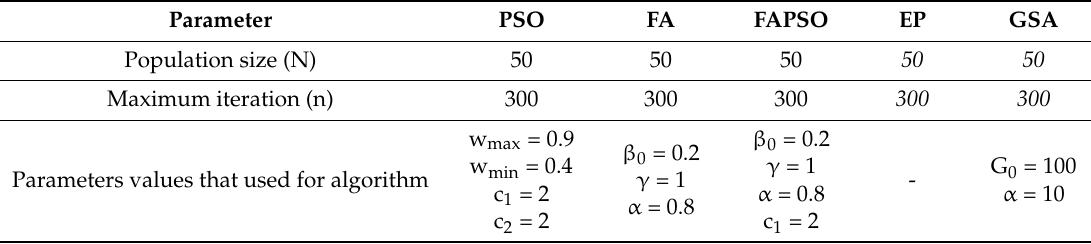
Table 3. Particle Swarm Optimization (PSO), Firefly Algorithm (FA), Firefly Algorithm—Particle Swarm Optimization (FAPSO), Evolutionary Programming (EP) and Gravitational Search Algorithm (GSA) Parameters Setting.